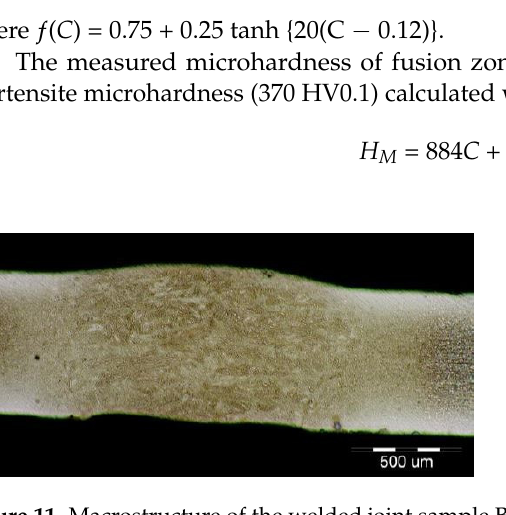
. Figure 12. Two-phase microstructure of DP 600 base material.